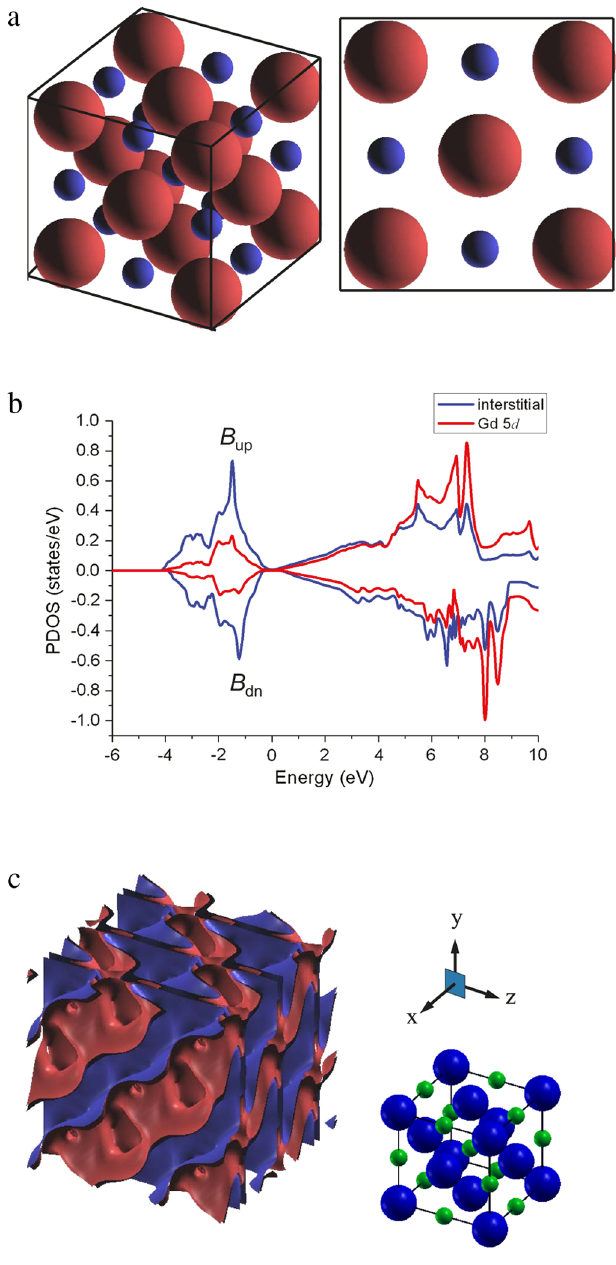
FIG. 7. (a) Calculated spin-density isosurfaces of a GdN bulk. The right plot is viewed along the direction perpendicular to a cube face and has the isosurfaces of only the nearest atoms plotted for better visualization. The plotted region represents a GdN conventional unit cell extended by 30% of the lattice constant, so that the spin isosurfaces of atoms at face centers and corners can be entirely plotted. Red stands for positive spin polarization, and blue for negative. Gd and N atoms have nearly spherical positive and negative isosurfaces, respectively. (b) Interstitial and Gd 5 d PDOS of a ferromagnetic GdN bulk. The main peaks of occupied majority- and minority-spin PDOS are labeled B up and B dn , respectively. (c) Isosurface of the spin probability density of the PDOS peak at the value of 0 : 0002 a (cid:3) 3 0